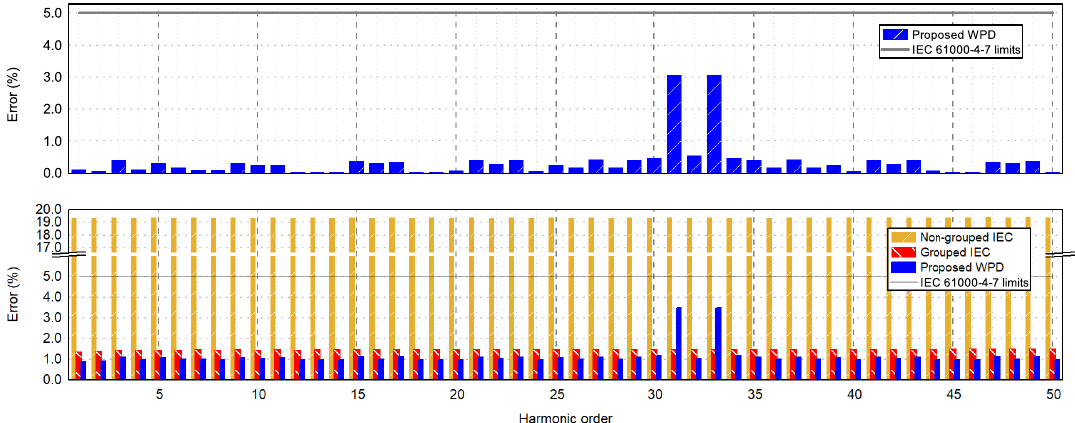
Figure 2. Top : errors of the proposed method with steady-state single frequency signals. Bottom : comparison of the error produced by the conventional FFT, the grouped IEC, and the WPD methods in case of single frequency signals, under fluctuating conditions (as explained in the text). The grey lines show the limits provided by IEC 61000-4-7 for stationary